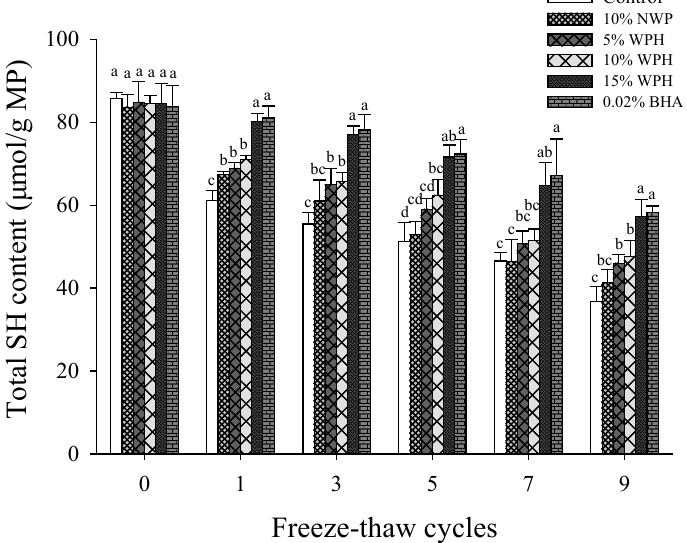
Figure 2. Changes in total sulfhydryl content (SH) of myofibrillar protein (MP) of multiple freeze–thaw (F–T) cycles of pork patties with different whey protein hydrolysate (WPH) contents. The significant differences among different samples are indicated by different lowercase letters (a–d). Control: without any additives in the sample; NWP: native whey protein; BHA: butylated hydroxyani- sole.